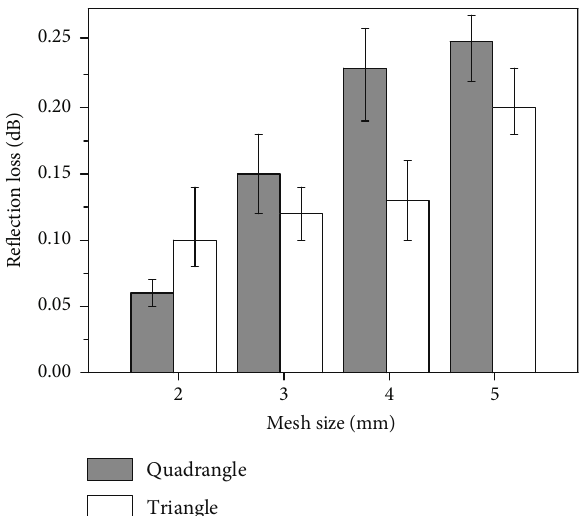
Figure 6: E ff ect of mesh shape on the re fl ection loss of the continuous fi ber reinforced thermoplastic composites re fl ecting